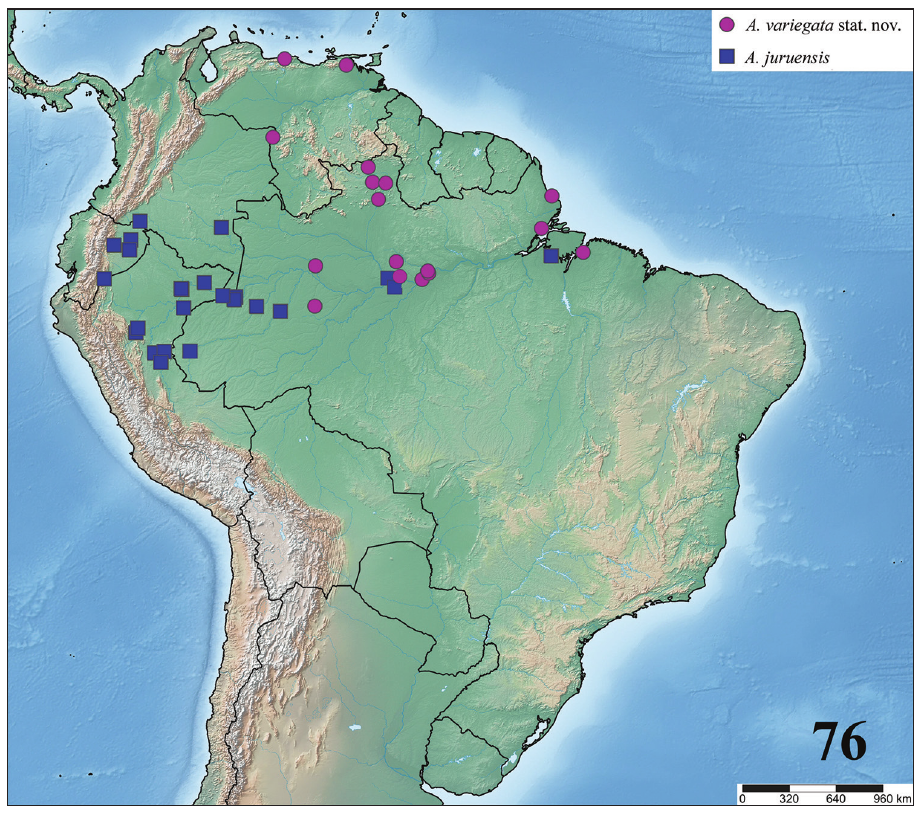
Figure 76. Map showing records of Avicularia variegata (F. O. Pickard-Cambridge, 1896) stat. n. and Avicularia juruensis Mello-Leitão,